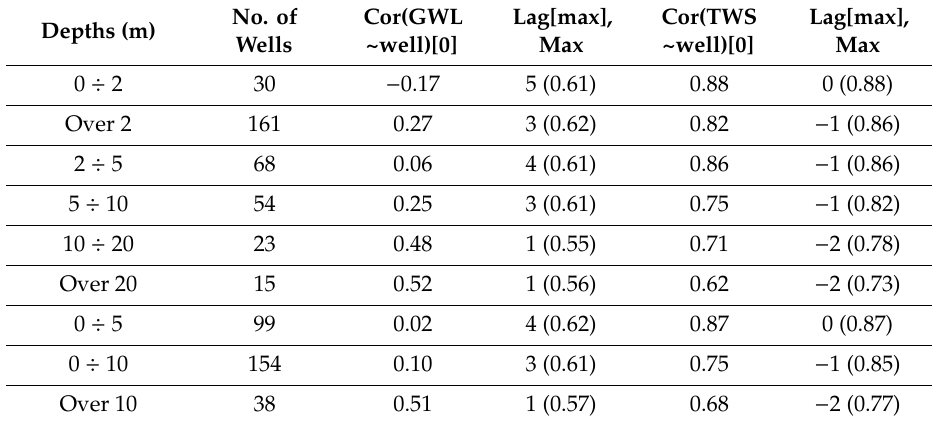
Table 2. Correlation of the thickness of the unsaturated zone at the location of the well variations with changes of GWS (GRACE / NOAH) and TWS (GRACE alone).